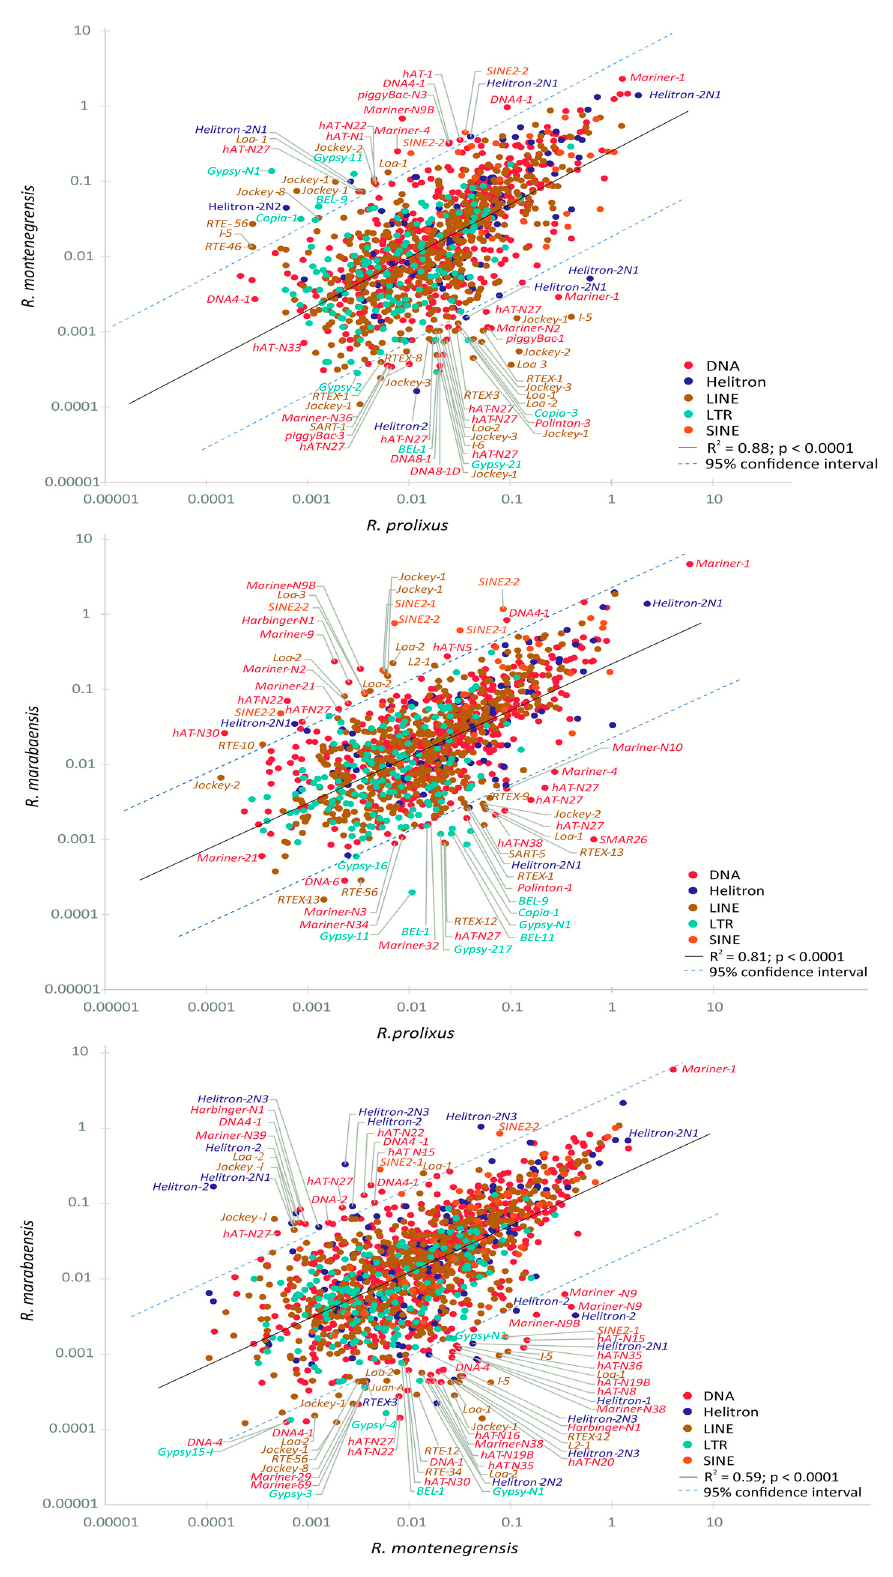
Figure 4. Scatter plot and analysis of linear regression of the relative genome proportions of shared TE families between the Rhodnius genomes in terms of genome percentage (log10 scale). Each dot represents a shared TE family, defined by the highest BLAST hit between the TE family reference contig of each species.